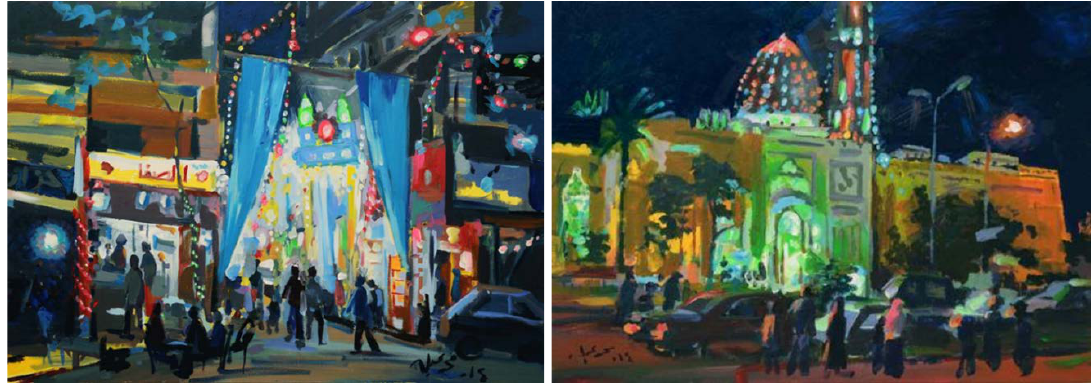
Figure 4. Mohamed Abla: Oil Painting on Canvas, 100 x 70 cm 2015